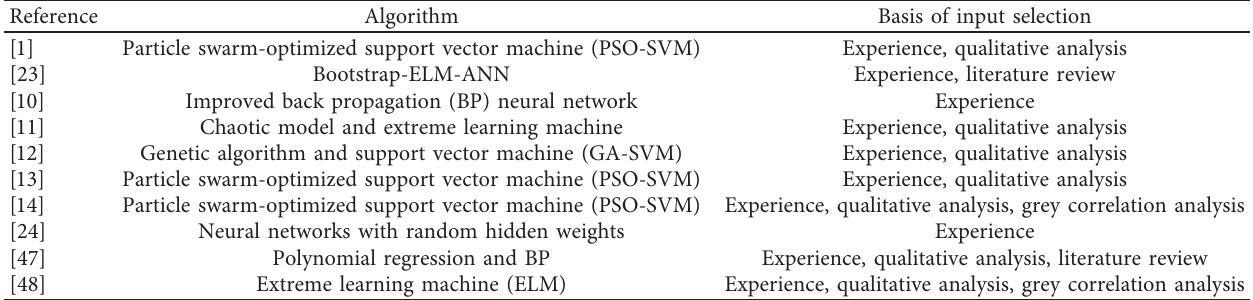
Table 2: Selected publications on input selection using a computational intelligence approach for landslide displacement prediction. Reference